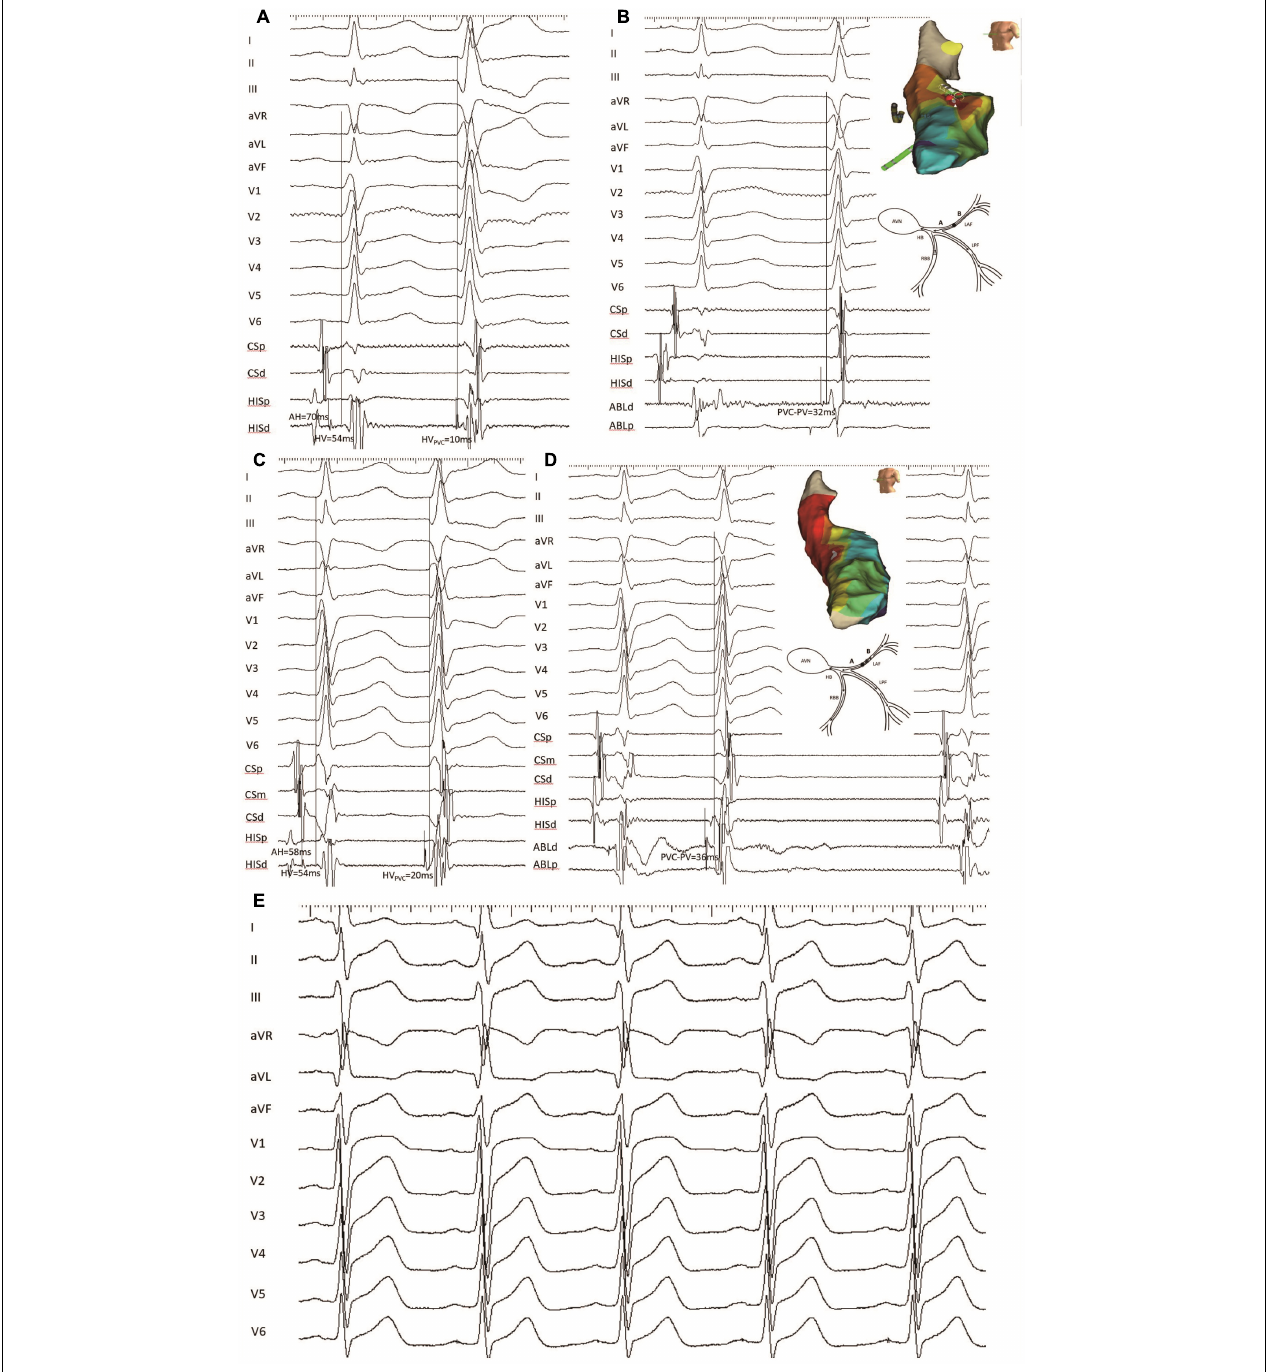
FIGURE 4 | An example of a failed patient with LAF-PVC who underwent a repeat ablation procedure (patient 22). (A) HV interval during NSR and PVC with mapping electrode positioned at the His bundle was 54 and 10 ms, respectively. (B) The target site was mapped with recordings of local fascicular potential-the onset of the QRS interval of 32 ms during PVC. Three-dimensional activation mapping of the left anterior area showed the target site, and a schematic diagram showed conduction within the Purkinje system. (C) During the repeat procedure, the HV NSR interval was the same as that during the first procedure, while the HV PVC interval was 20 ms; the QRS duration after ablation decreased from 96 to 80 ms, and the axis deviation increased to 21 ◦ . Note that NSR-QRS morphology had a slight change, and the QRS duration of PVC was slightly narrower than that before ablation. (D) The same site was identified, and the earliest retrograde PP with 36 ms was mapped and had successful ablation. Three-dimensional activation mapping of the left anterior area showed the target site and a schematic diagram showing the slow conduction within the LAF fiber. It is noted that the target PP was sharp during PVC, while the PP was fragmented during NSR. (E) The electrocardiogram showed the left anterior block after successful ablation. CS, coronary sinus; PP, Purkinje potential; the other abbreviations are as in Figure 2 .